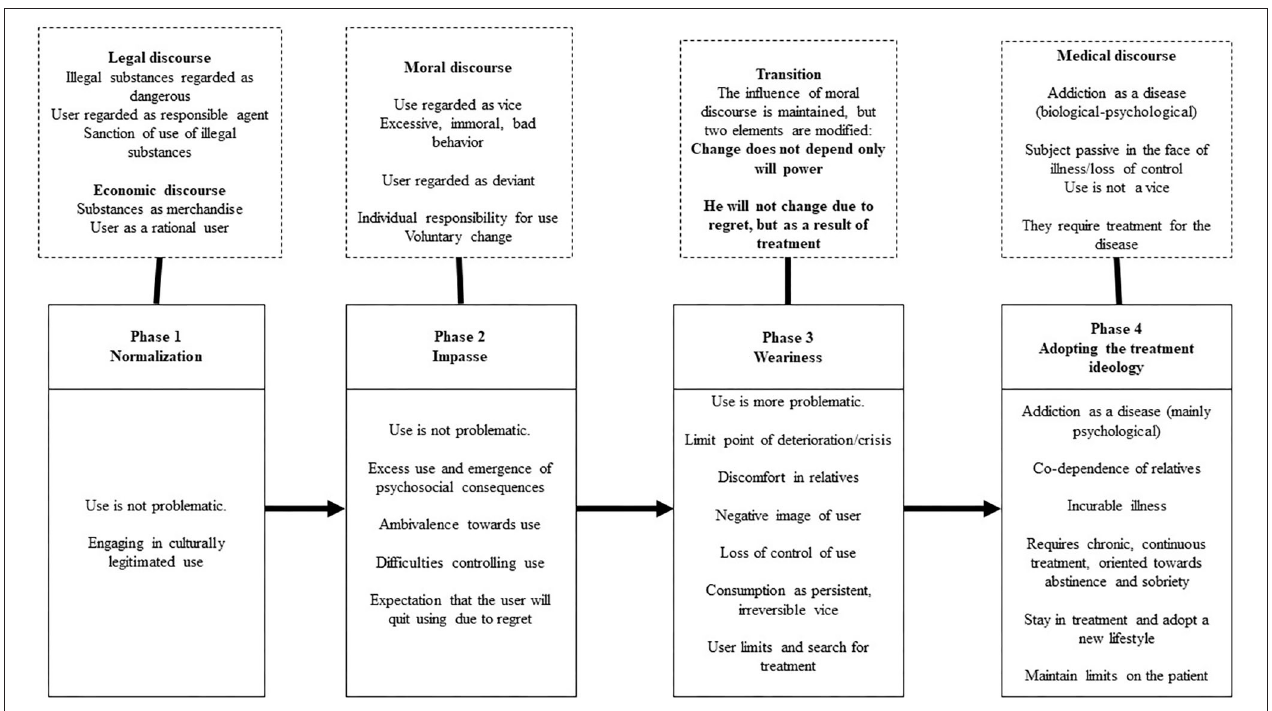
FIGURE 1 | Phases in the construction of use as a problem by family